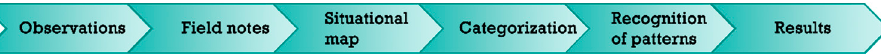
Figure 1. Flowchart of work progress.